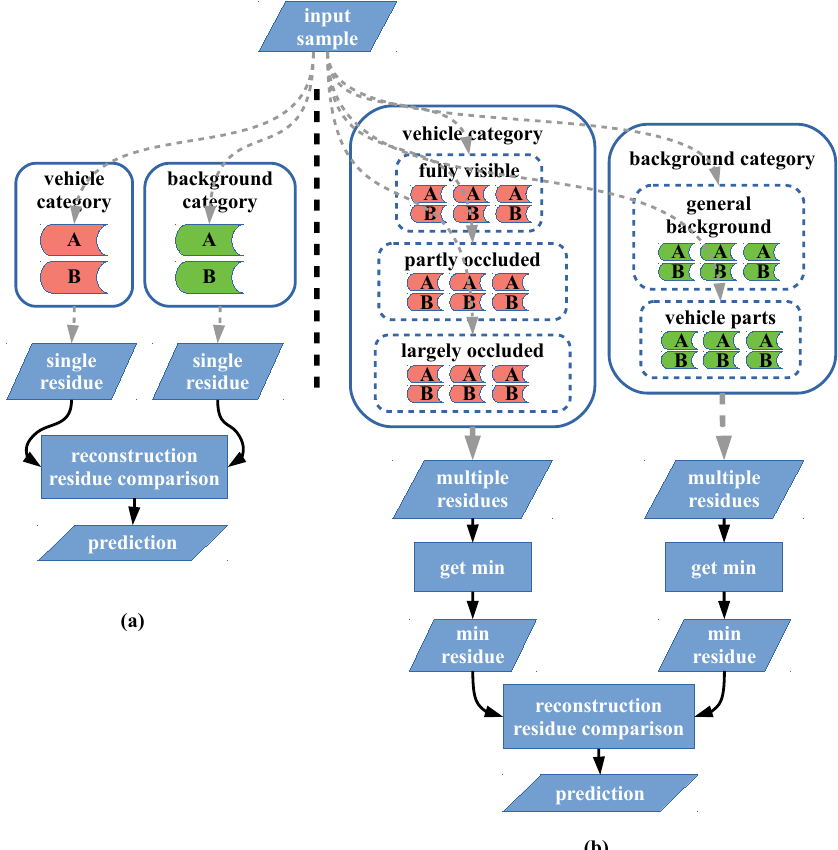
Figure 5. Two kinds of subcategory divisions in SDD ensemble and corresponding classification workflows: ( a ) no subcategory; ( b ) multiple subcategories in each